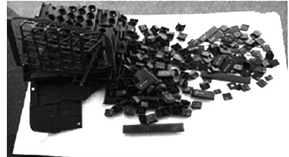
Figure 1. Discarded keyboard plastic waste used in the determination of kinetic